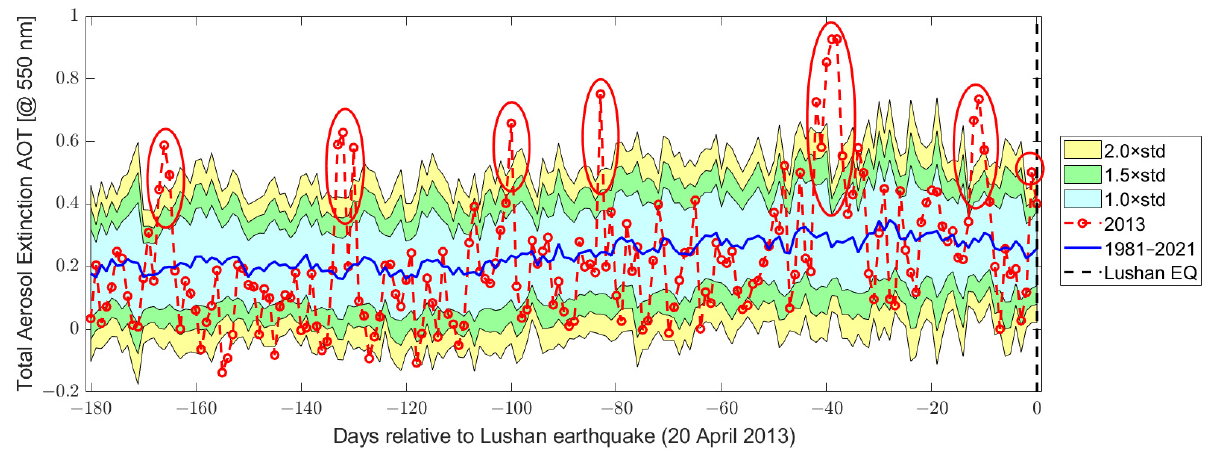
Figure 13. Aerosol levels from the six months before the Mw 6.7 Lushan 2013 earthquake. The time series for the six months before the Lushan 2013 earthquake of sulfur dioxide levels is shown in Figure 14, and red circles depict the positive anomalous values. In particular, one value (7 February 2013, 71 days before the earthquake) is exceptionally high but doesn’t persist for more than one day. Other days present persistent anomalies, such as 1–2 November 2012 ( − 169 days with respect to the earthquake), 9–10 December 2012 ( − 130 days with respect to the earthquake), and 19 and 20 February 2013 ( − 59 days with respect to the earthquake).